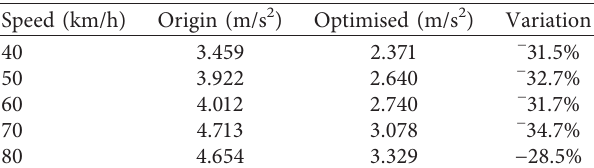
Table 4: Comparison of carriage acceleration r.m.s. before and after